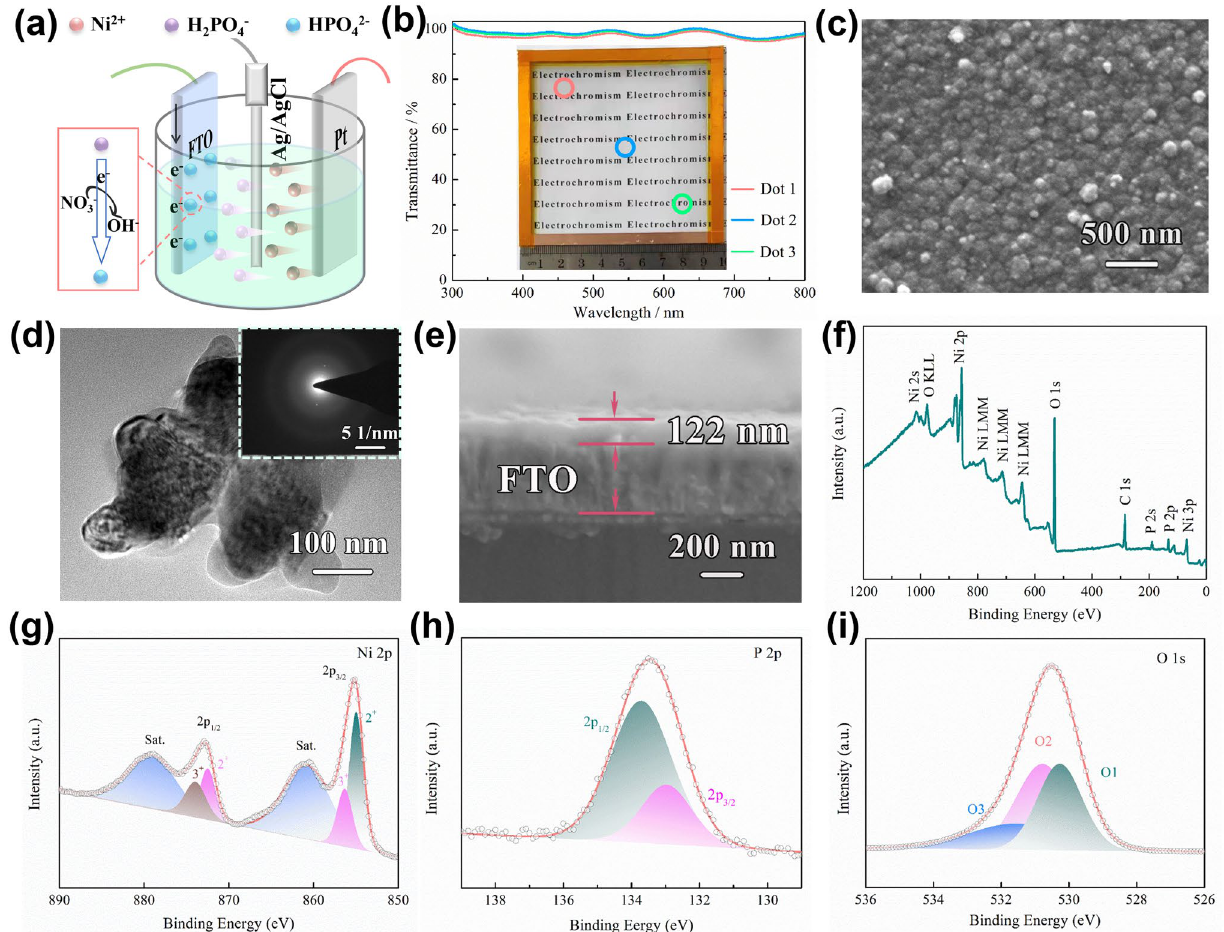
Fig. 1 a Schematic illustration of the NHP film obtained by cyclic voltammetric electrodeposition from − 1.2 to 0.2 V ( vs. Ag + /Ag) at 20 mV s −1 in a three-electrode system. b Transmission spectra of three different points selected from a 10 × 10 cm 2 NHP film as shown in the inset. c SEM images of NHP film prepared by electrodeposition on FTO substrates, d TEM image and the corresponding SAED pattern (inset) of the NHP nanomaterial, and e represents the cross-sectional SEM of NHP film. f XPS spectrum of the NHP film. g Ni 2 p , h P 2 p and i O 1 s spectrum of the NHP